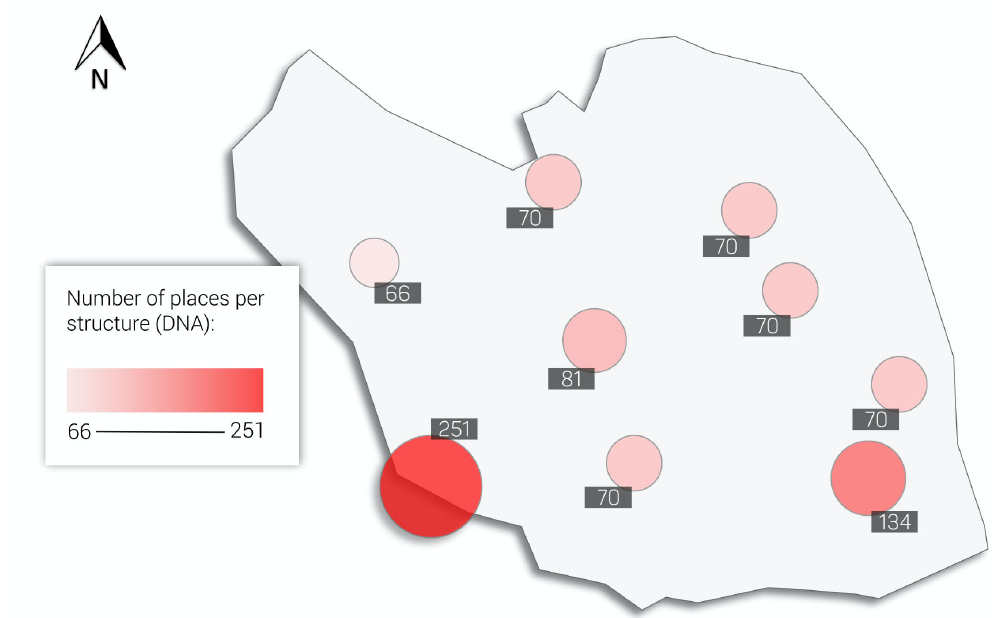
Figure 2. Schematic dispersion of DNA applicants at departmental level of the western city: Number of places per structure. Schematic map based on fieldwork and designed by Jules Jung (Blitzz